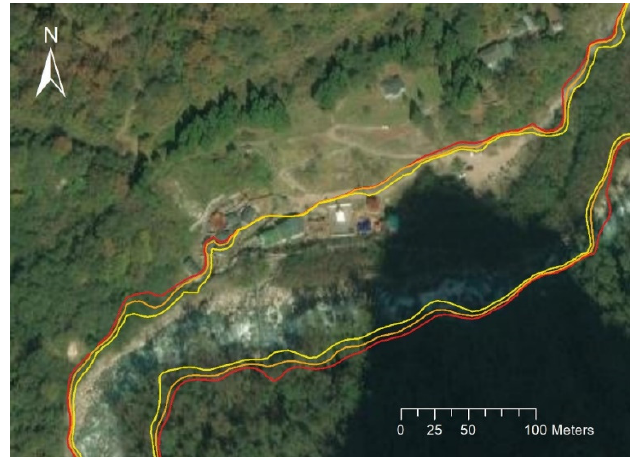
Figure 6. Inundation extent (red: worst case, orange: average GLOF, yellow: best case) around Gasa Hot Springs. Backgound map: World Imagery (Source: Esri, Maxar, Earthstar Geographics, USDA FSA, USGS, Aerogrid, IGN, IGP, and the GIS User Community).